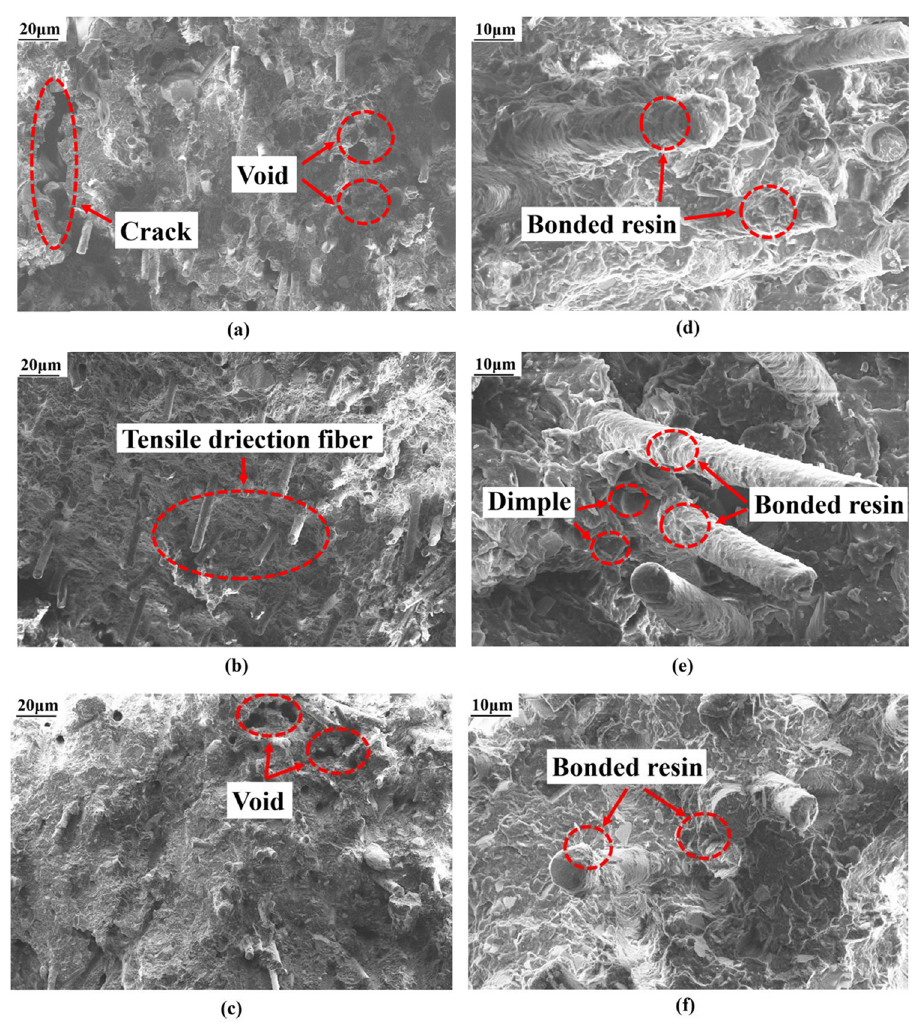
Figure 10: Surface fractography of the plate treated by the three routes: ( a ) and ( d ) route I ( b ) , ( e ) route II, and ( c ) and ( f ) route III, in which ( a ) – ( c ) were obtained with a magni fi cation of 500, and ( d ) – ( f ) were obtained with a magni fi cation of 1,000